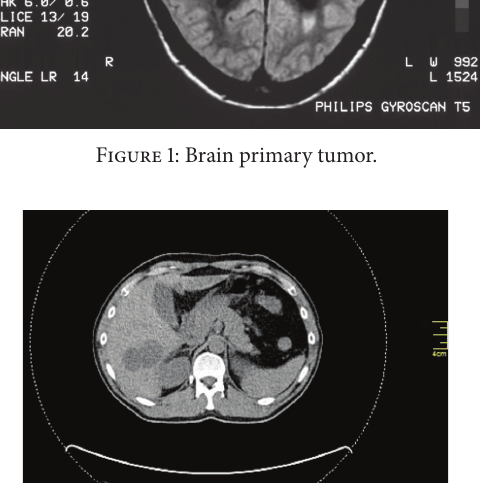
Figure 2: Liver metastases, segment VI.